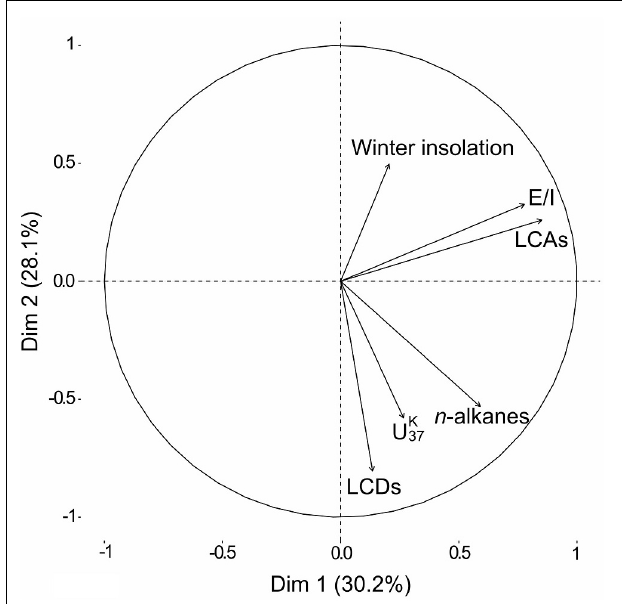
FIGURE 5 | Principal Component Analysis (PCA) visualization of lipid biomarker composition and January insolation at 40 ◦ N (Berger and Loutre, 1991) over the Holocene. Accordingly, the winter solar insolation was likely a controlling parameter of the Evaporation-to-Inflow ratio E/I, which in turn affected the presence of LCAs. Conversely, the concentration of both LCDs and n-alkanes seemed to be controlled by temperature (U K 37 index).